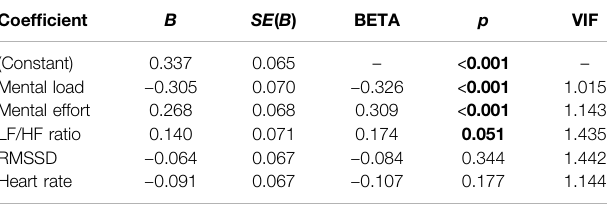
TABLE 5 | Linear regression analysis with objective and subjective measures of cognitive load as predictor variables for task performance (for the total sample).